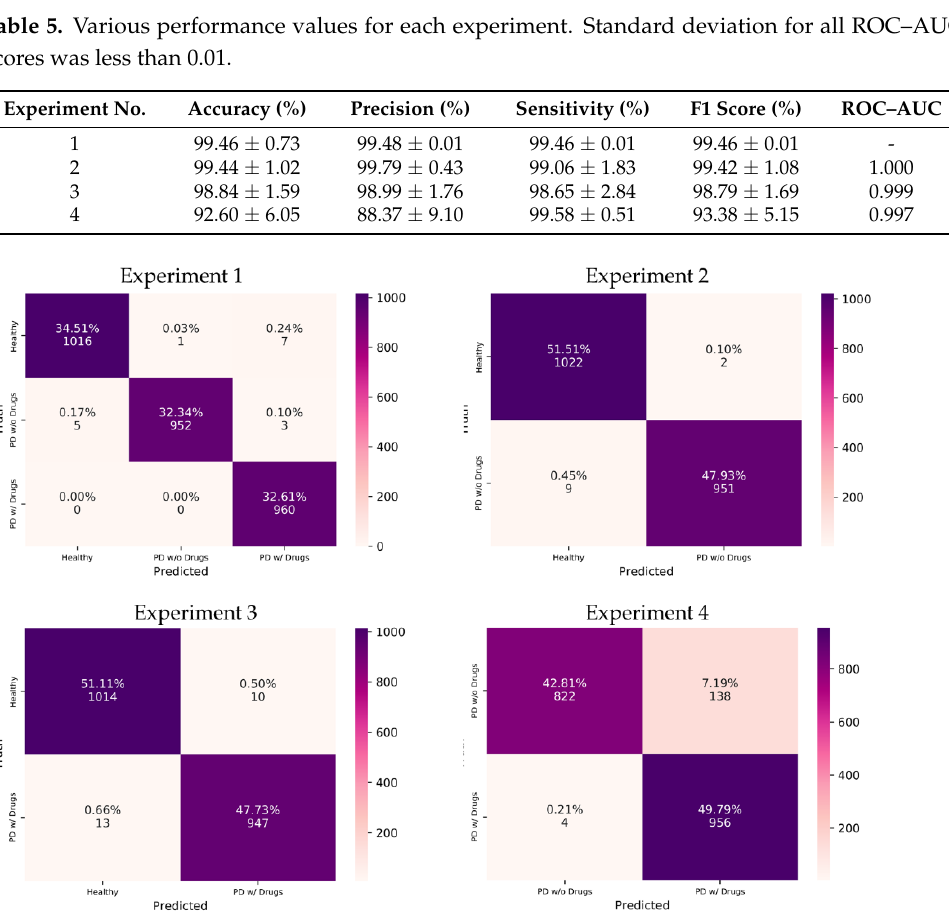
Figure 6. Confusion matrix of respective experiments. w/o, without; w/, with. Drugs refer to the dopaminergic medications taken by PD patients. Table 6. Multiclass performance values for each class in Experiment 1. Drugs refer to the dopamin- ergic medications taken by PD patients.